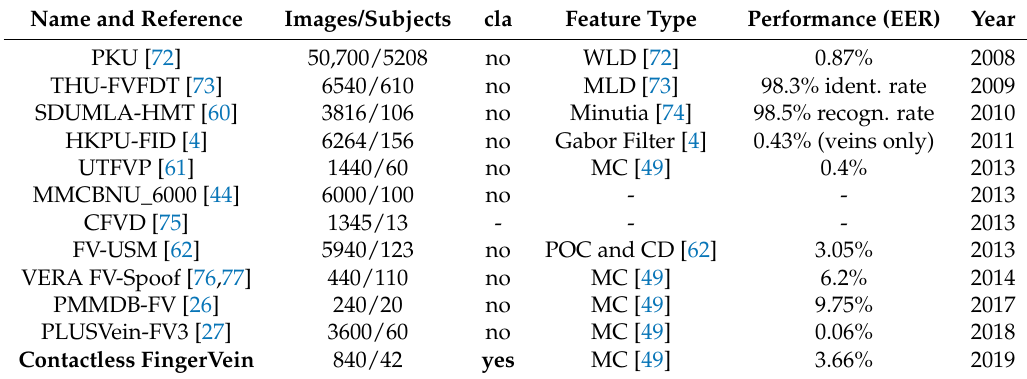
Table 4. Performance results of other publicly available finger vein datasets, ordered by publication year, ”-” means that this information is not available. The “cla” column indicates contactless